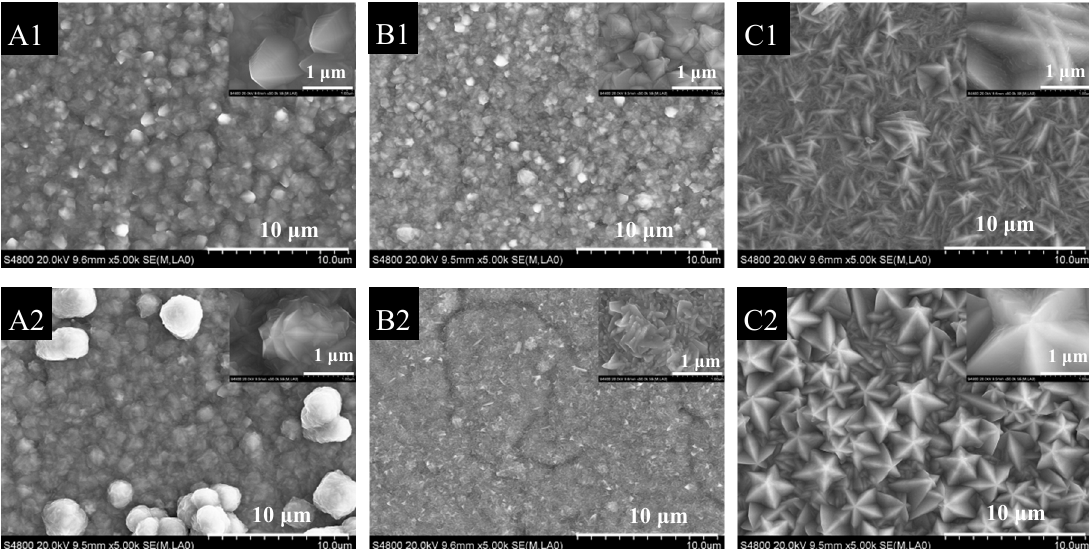
Figure 4. SEM images of TiN at 850 ◦ C for 1.5 h at di ff erent flow rate of each component; A group is the flow rate of H 2 diluent gas (L / min): A1 —1.29, A2 —0.95; B group is the flow rate of N 2 (L / min):